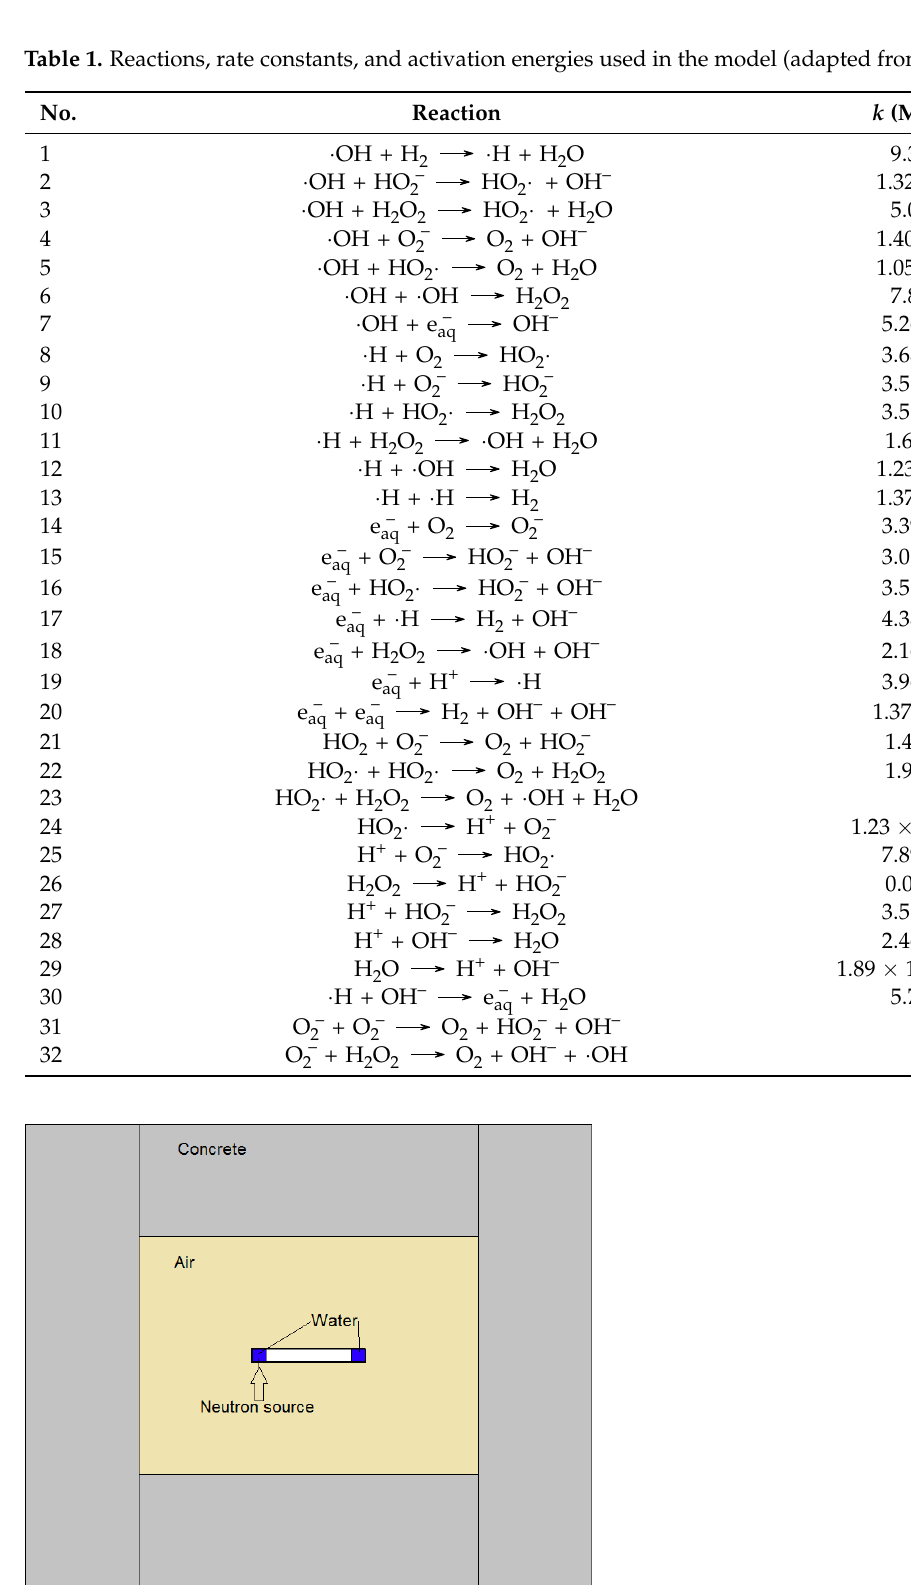
Figure 2. Simplified scheme of SORGENTINA neutron